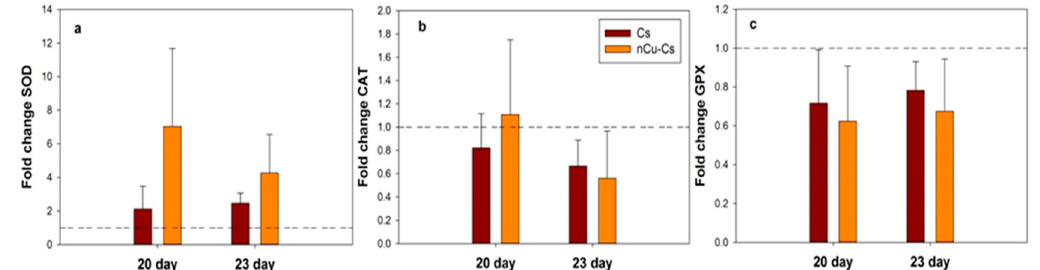
Figure 1. Expression of superoxide dismutase (SOD) ( a ), catalase (CAT) ( b ), and peroxidase glutathione (GPX) ( c ) genes in tomato leaves at 20 and 23 days after transplant. Cs = 1 g Cs-PVA hydrogel; nCu-Cs = 10 mg Cu NPs + Cs-PVA. Data represent the mean ± the standard error and the reference line represents the constant value of the absolute control.